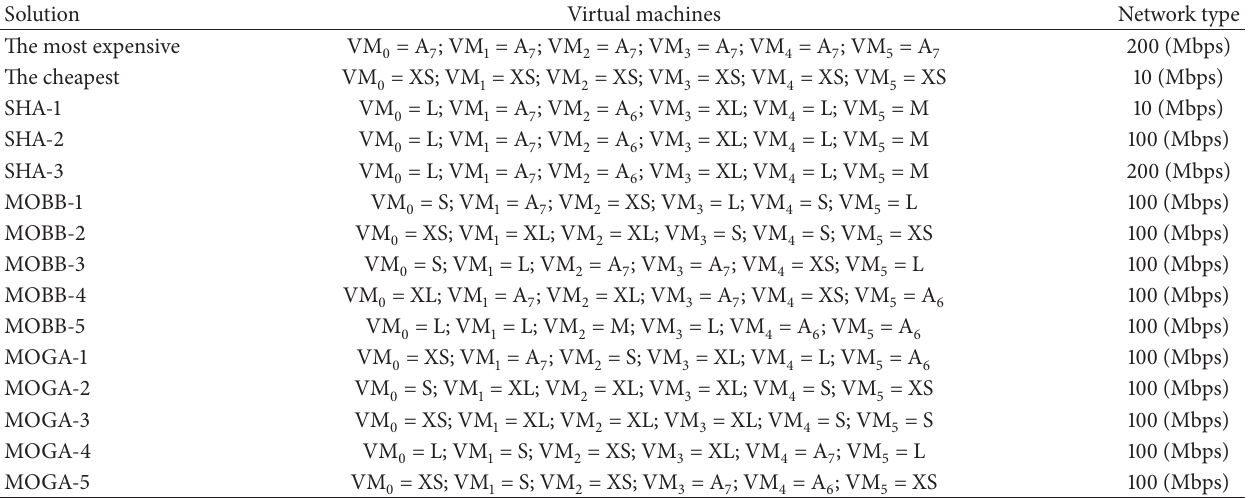
Table 10: Proposed paretooptimal VM and network configurations for workload 1.